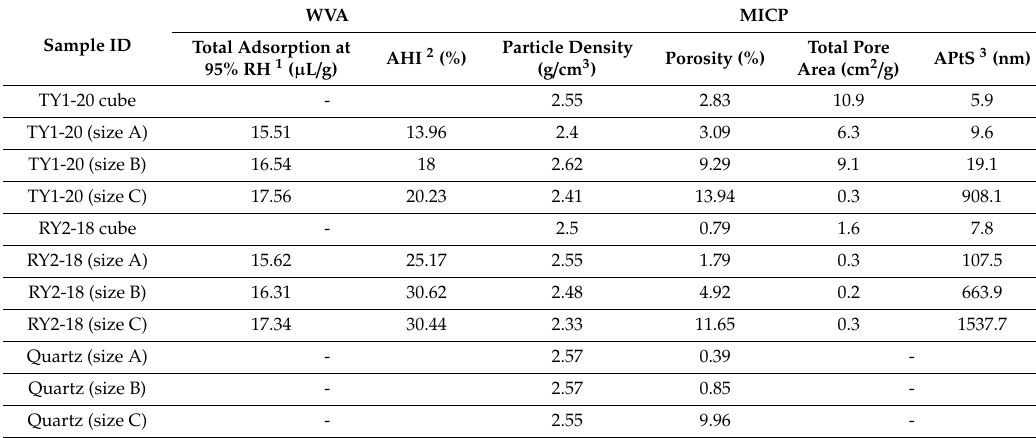
Table 3. Parameters obtained from water vapor adsorption (WVA) and MICP